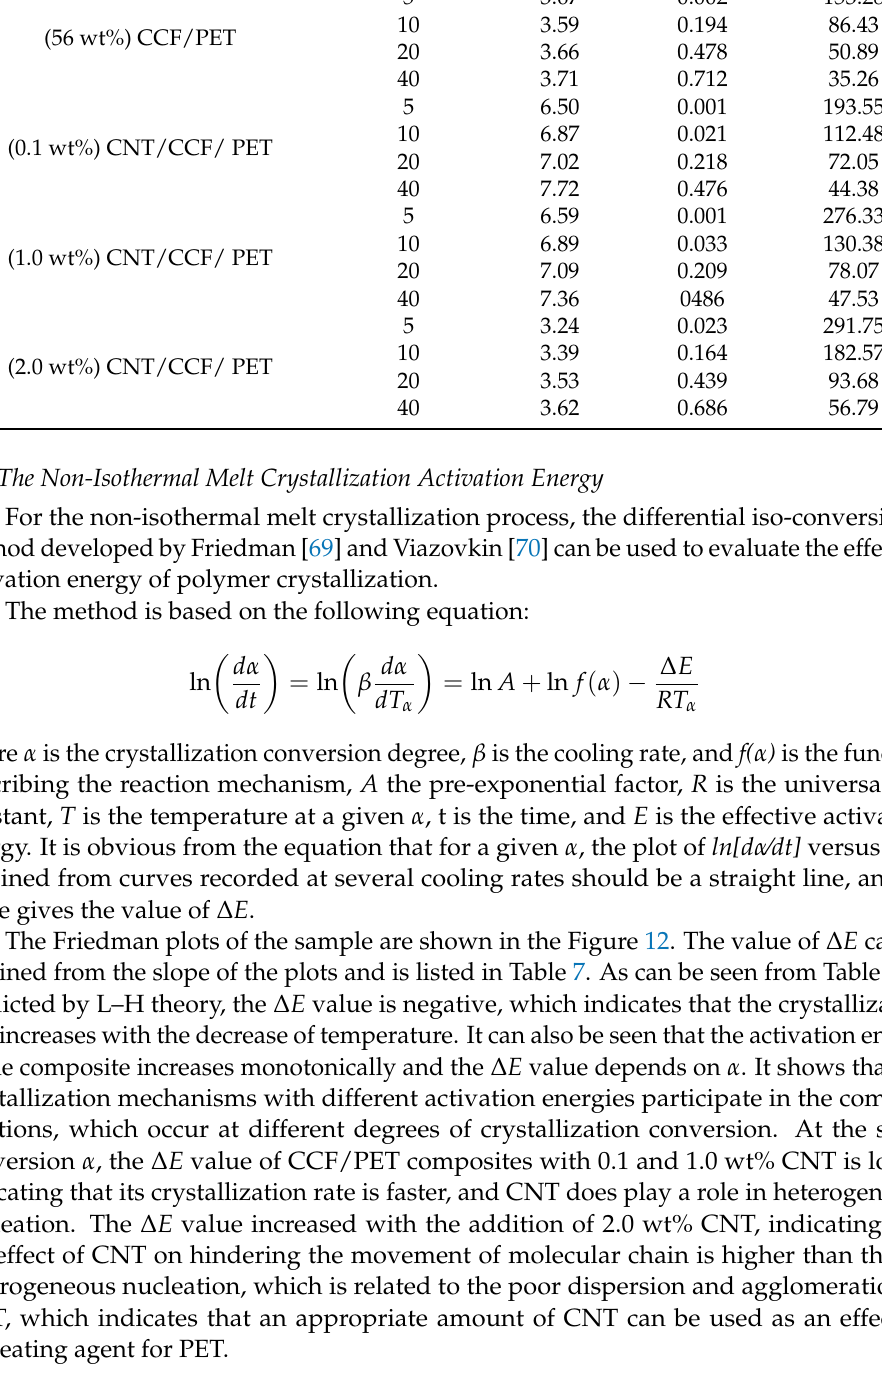
Table 6. Non isothermal crystallization kinetic parameters based on Jeziorny modified Avrami equation.